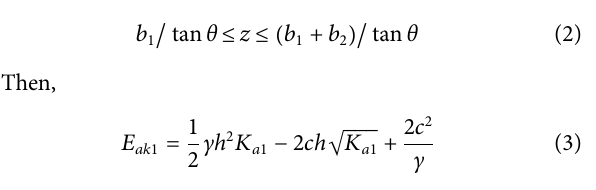
Frontiers in Earth Science |